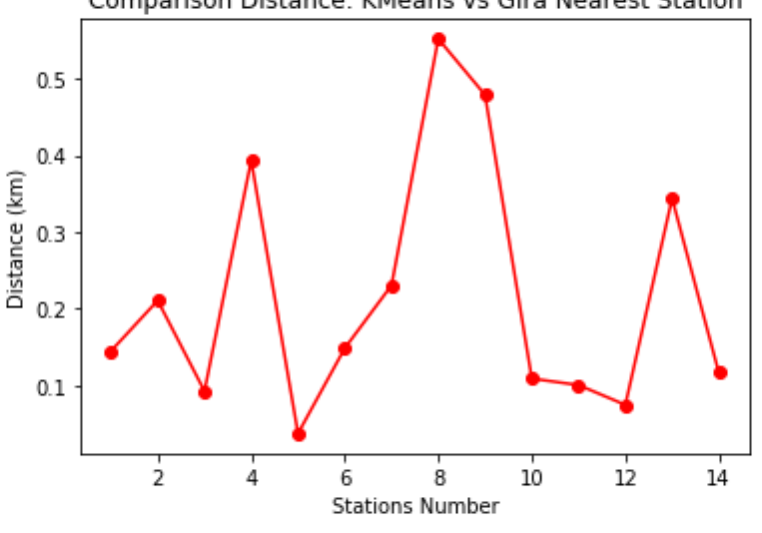
Figure 11. Distancing comparison: K-Means output vs. Gira bicycles docking